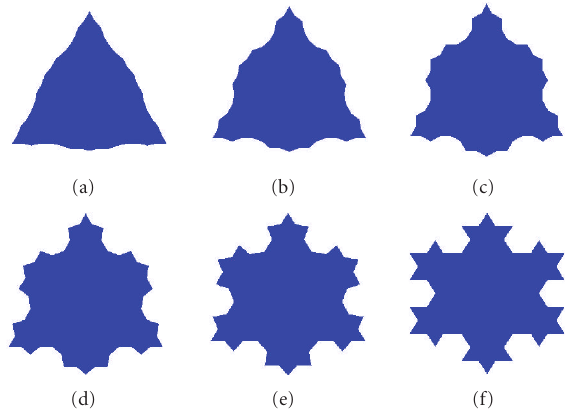
Figure 2: Second iterated Koch fractal boundary microstrip antennas with indentation angles (a) 10 ◦ , (b) 20 ◦ , (c) 30 ◦ , (d) 40 ◦ , (e) 50 ◦ , and (f) 60 ◦ .